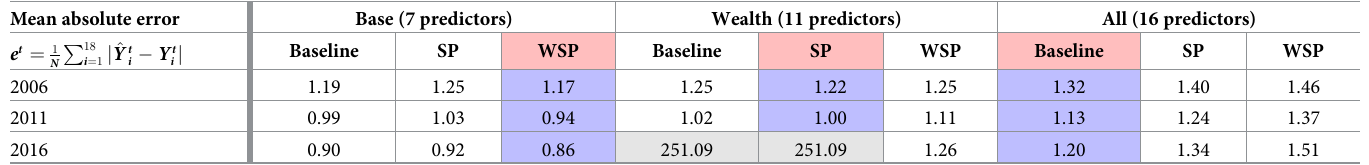
Table 1. Model evaluation. We report the mean absolute error for each model across all districts averaged over a 1000 trials. The cells colored in blue show the model with the lowest margin of error for each feature category, whereas grey cells demonstrate ties among two models. The model highlighted in red indicates the model with the low- est margin of